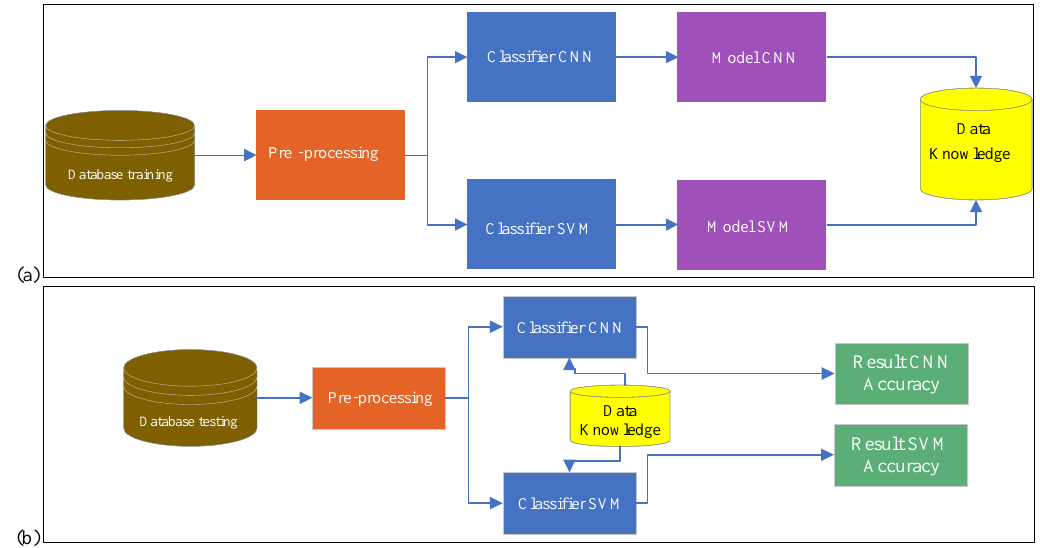
Figure 3. (a) Training process of both machine learning algorithms; (b) Testing process using both models of